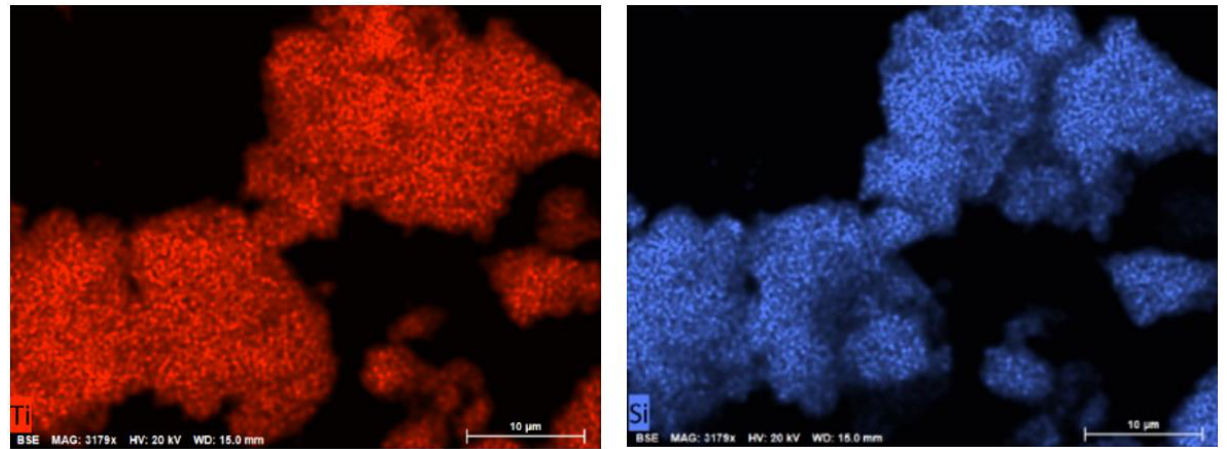
Figure 9. SEM backscatter image with XPS elemental mapping. Silica fume grains are shown in blue hues, while titanium is shown in red.